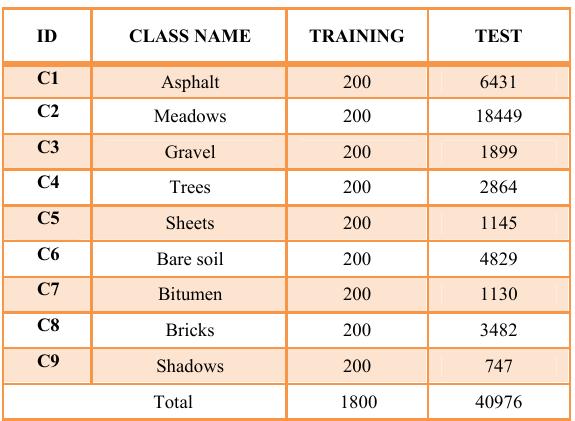
Table 1 Number of training and test samples used in the Pavia University data set.